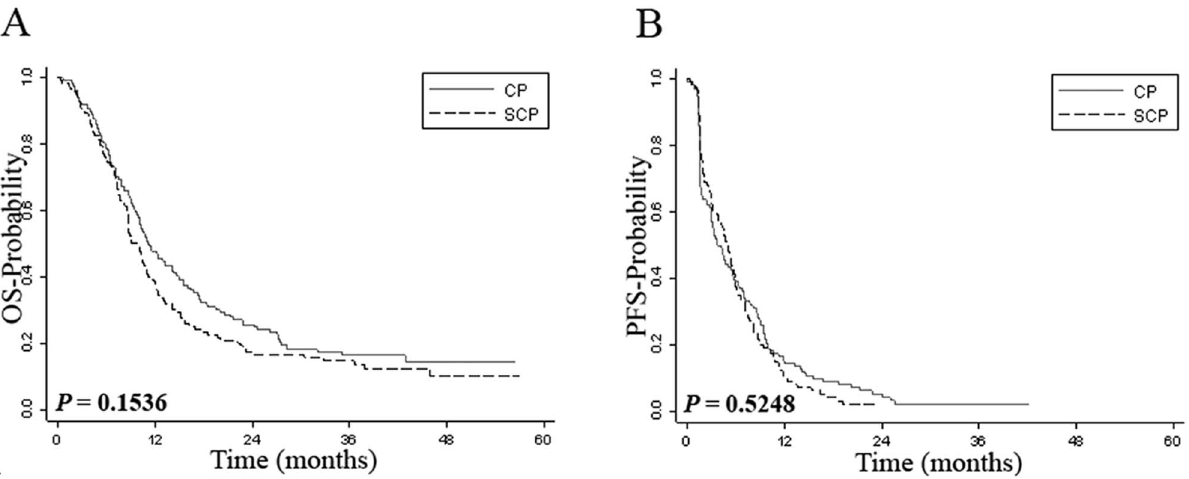
Figure 1. Kaplan-Meier survival analysis by treatment arm. Panel A shows Kaplan-Meier estimates of overall survival while panel B shows Kaplan-Meier estimates of progression-free survival for patients treated with sorafenib, carboplatin and paclitaxel (SCP) or carboplatin and paclitaxel (CP).